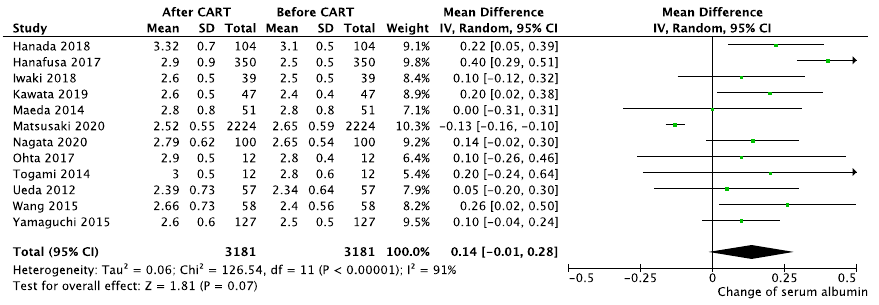
Figure 3. Change in serum albumin before and after CART.